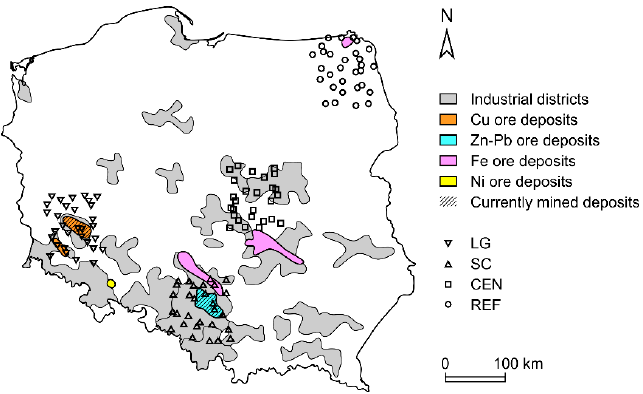
Figure 1. Location of sampling sites (see the text for explanation) in relation to industrial districts and major metal ore deposits in Poland.